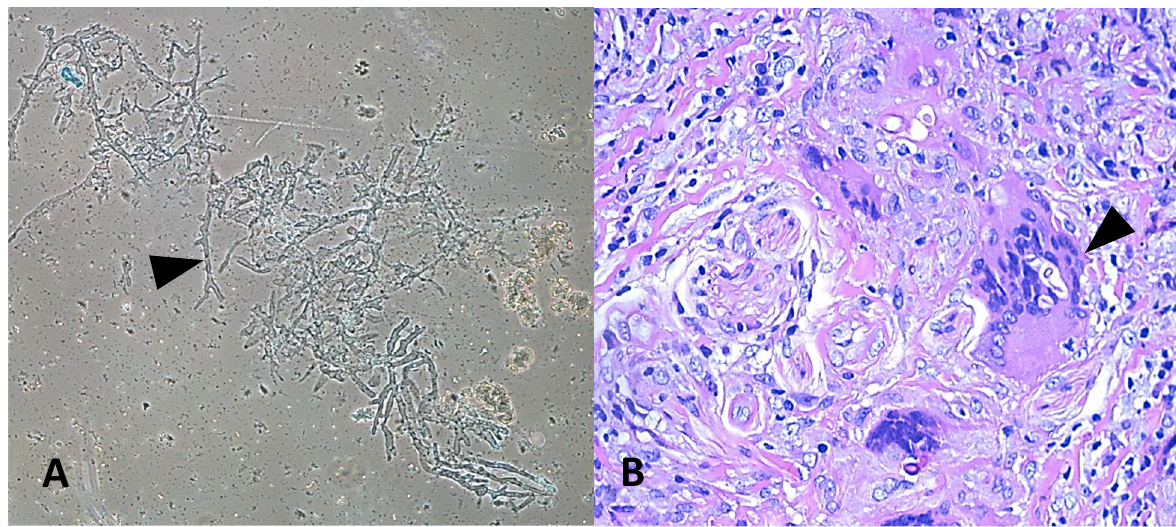
Figure 2. ( A ) Potassium hydroxide mount of nasal scraping showing broad aseptate hyphae (indicated by triangle)(10×) ( B ) histopathological findings of biopsy from exposed nasal mucosa showing non-necrotizing granulomas with broad aseptate fungal profiles (indicated by triangle).